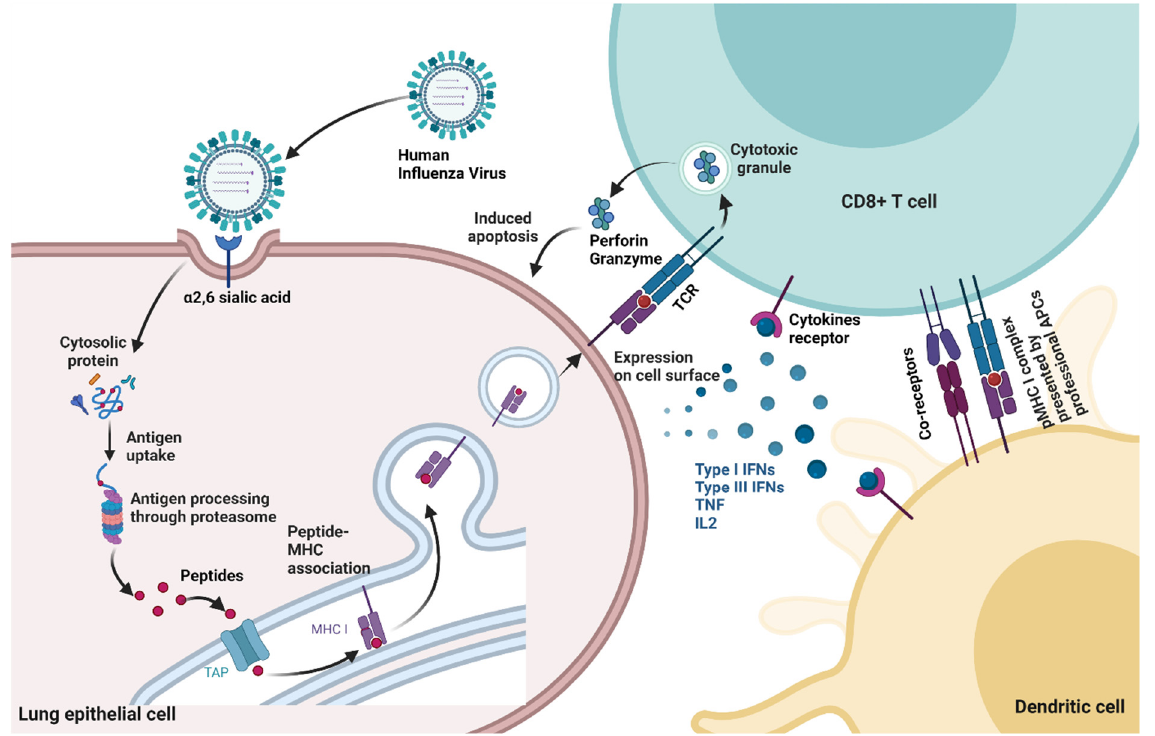
Figure 2. T cell recognition of influenza virus-infected cells. Upon infection, respiratory epithelial cells and professional antigen-presenting cells (APCs), such as dendritic cells (DCs), process the viral proteins and present them as peptides in complex with MHC-I on the cell surface. Specific T cell receptors (TCR) expressed on the CD8 + T cells then recognize these peptide/MHC-I complexes. Upon engagement, the CD8 + T cells become activated and secrete cytotoxic granules (i.e., granzymes, perforin) targeting the infected cell to induce its death and produce proinflammatory cytokines (i.e., IFNs, TNF, and IL2). Image created with BioRender.com. (Accessed on 14 September 2022)